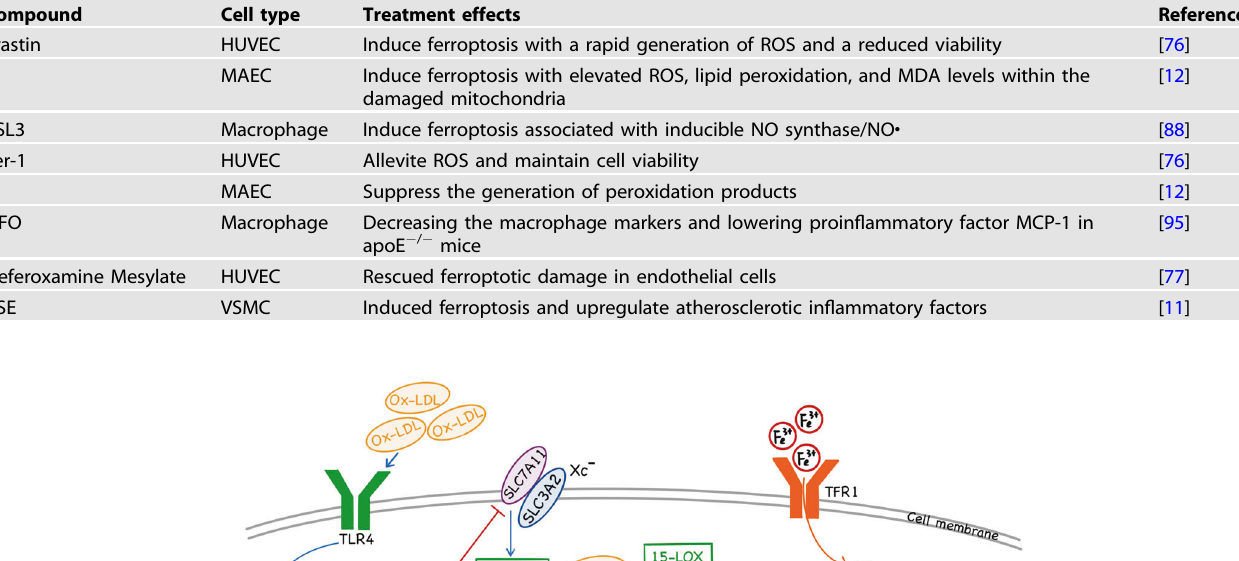
Table 2. Small molecules and drugs that interfere with ferroptosis in AS-related cells.